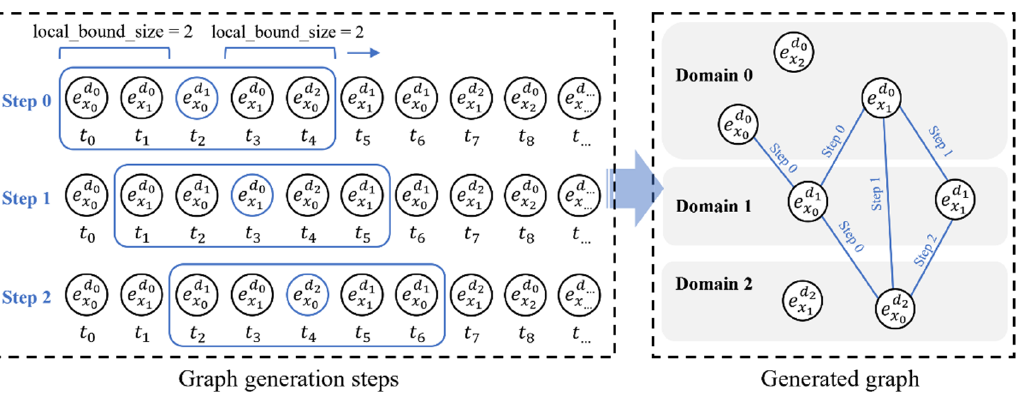
Figure 3. The method of building a cross-domain event association graph: the left side of the figure is the sampling step, and here are three steps, namely Step 0, Step 1, and Step 2, and the sampling window local_bound_size = 2. The right side of the figure is the event association graph obtained after sampling, which contains both domain information and event category information.